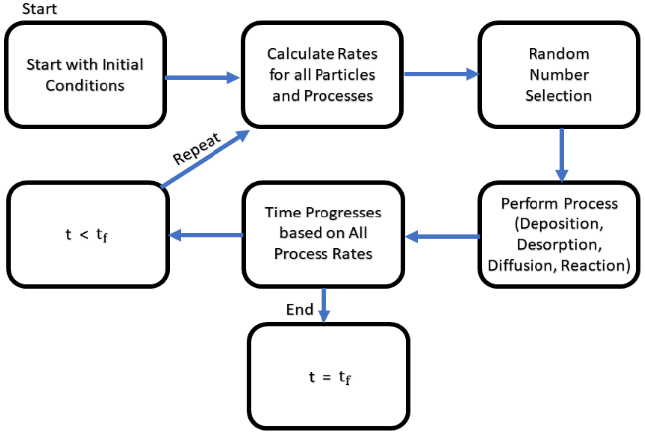
Figure 6. Flowchart of the Monte Carlo model.